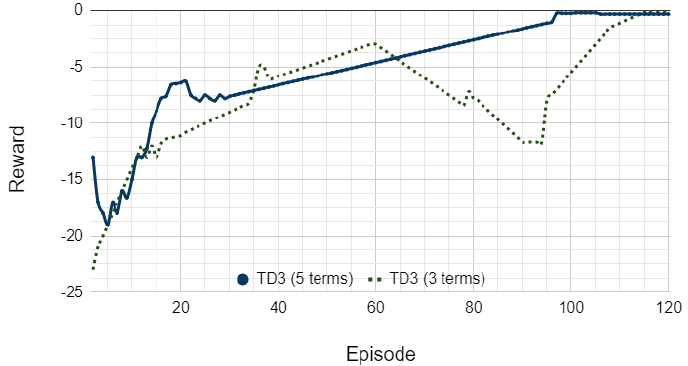
Figure 6. This result comparison uses the proposed twin-delayed deep deterministic policy gradient algorithm under a 3-term and 5-term reward function, where 3 terms refer to the first three terms in Equation (8), and 5 terms refer to the entire Equation (8). The reward shown here refers to the running average reward